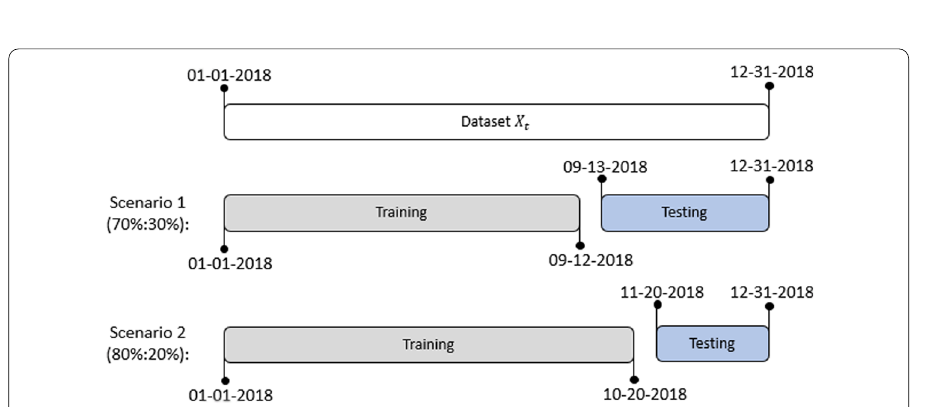
Fig. 2 Training testing data